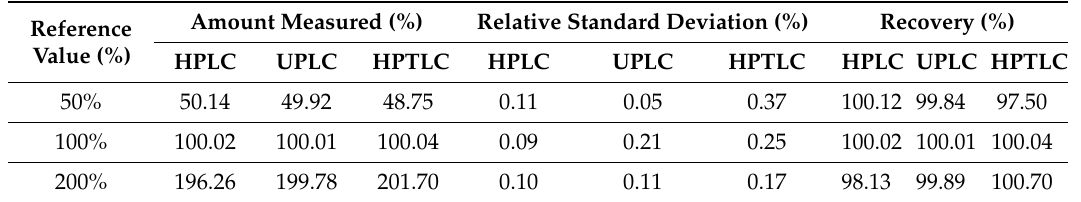
Table 4. Accuracy of the developed method.